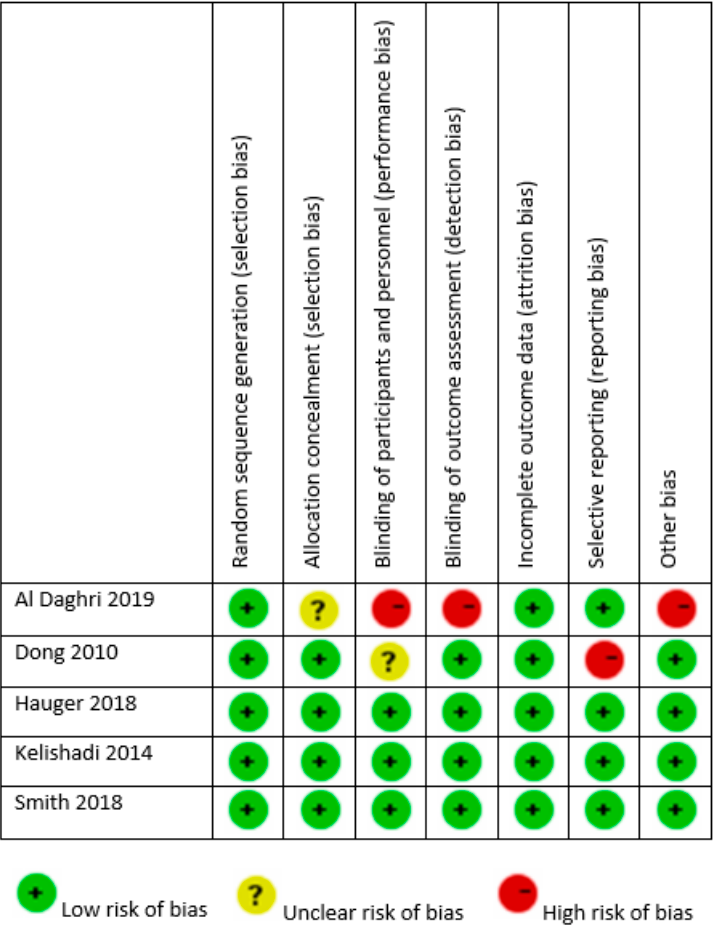
Figure 3. Risk of bias of randomized controlled trials.